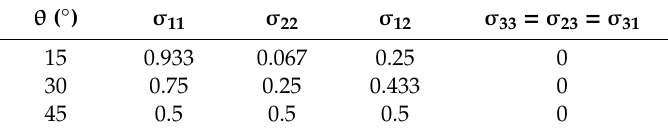
Table 4. Global stress analysis results for unit-applied